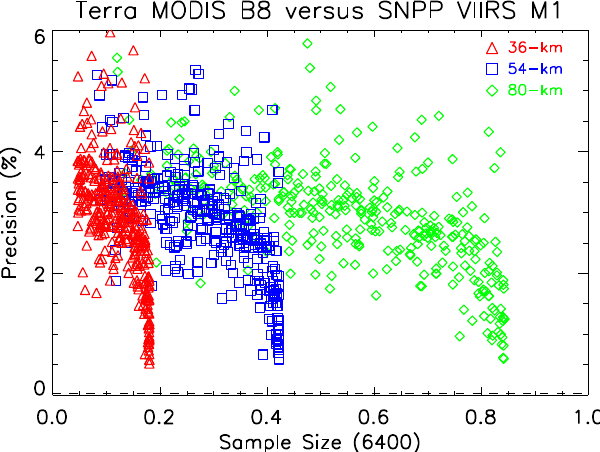
Figure 15. Precision versus sample size for six inter-RSB comparisons of Aqua MODIS versus SNPP VIIRS under no sample constraint demonstrating scaling phenomenon.